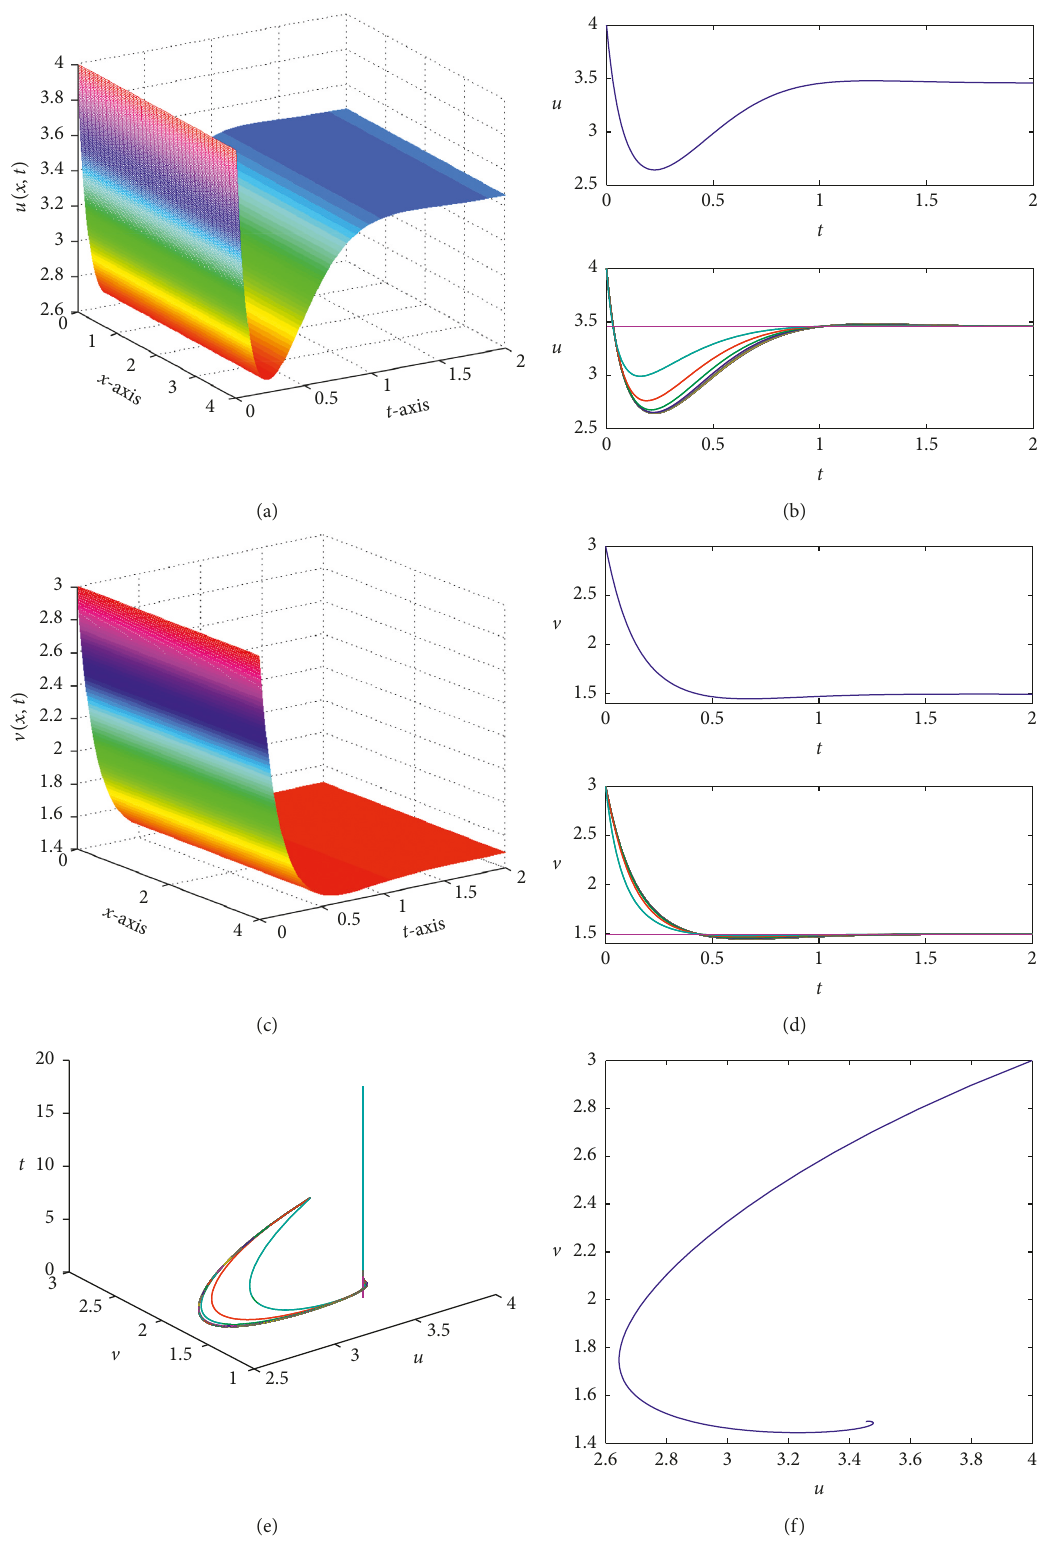
Figure 1: Global stability of the positive equilibrium point ( 3 . 4581 , 1 . 4916 ) of system (1) with the initial value ( u ( 0 , x ) ,v ( 0 , x )) � ( 4 , 3 ) . (a) The numerical solution surface of u ( x, t ) , (b) the numerical solution curve of u ( t, 2 ) and u ( t ) , (c) the numerical solution surface of v ( t, x ) , (d) the numerical solution curve of v ( t, 2 ) and v ( t ) , (e) the numerical solution surface of u ( t ) and v ( t ) , and (f) the numerical solution curve of u ( t, 2 ) and v ( t, 2 )